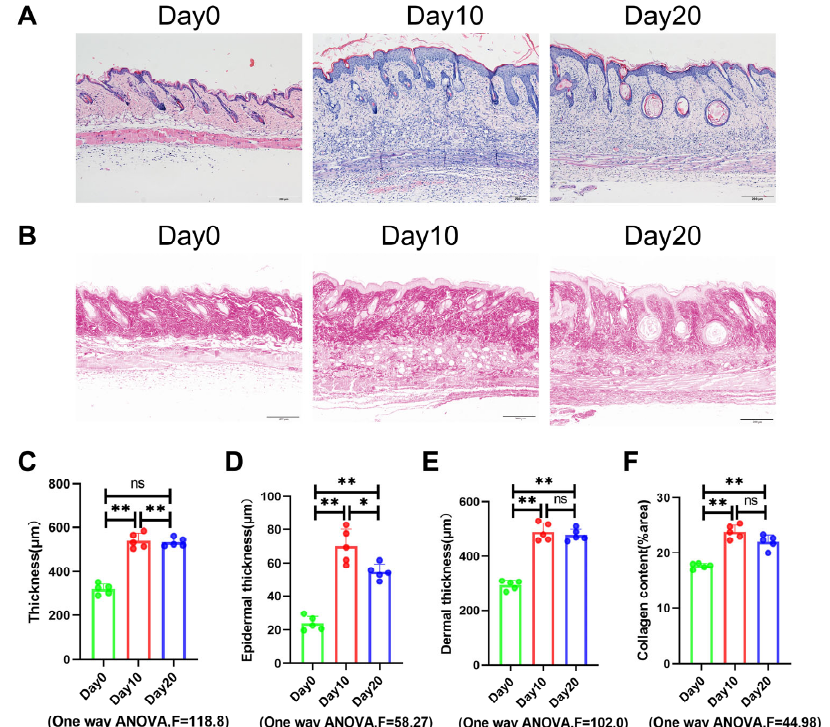
Figure 8. Rosacea-like skin lesions induced by 10 days of LL-37 administration exhibited both epidermis and dermis thickening accompanied by an increase in collagen density, and neither the epidermis nor the dermis could return to normal thickness after halting administration for 10 days. ( A , C – E ) Hematoxylin-eosin (H&E) staining of lesioned skin (scale bar = 200 µm). ( B , F ) Representative skin sections stained with Van Gieson staining (VG staining) (scale bar = 200 µm). Data are presented as the mean ± SD; n = 5 for each group. * p < 0.05, ** p < 0.01.